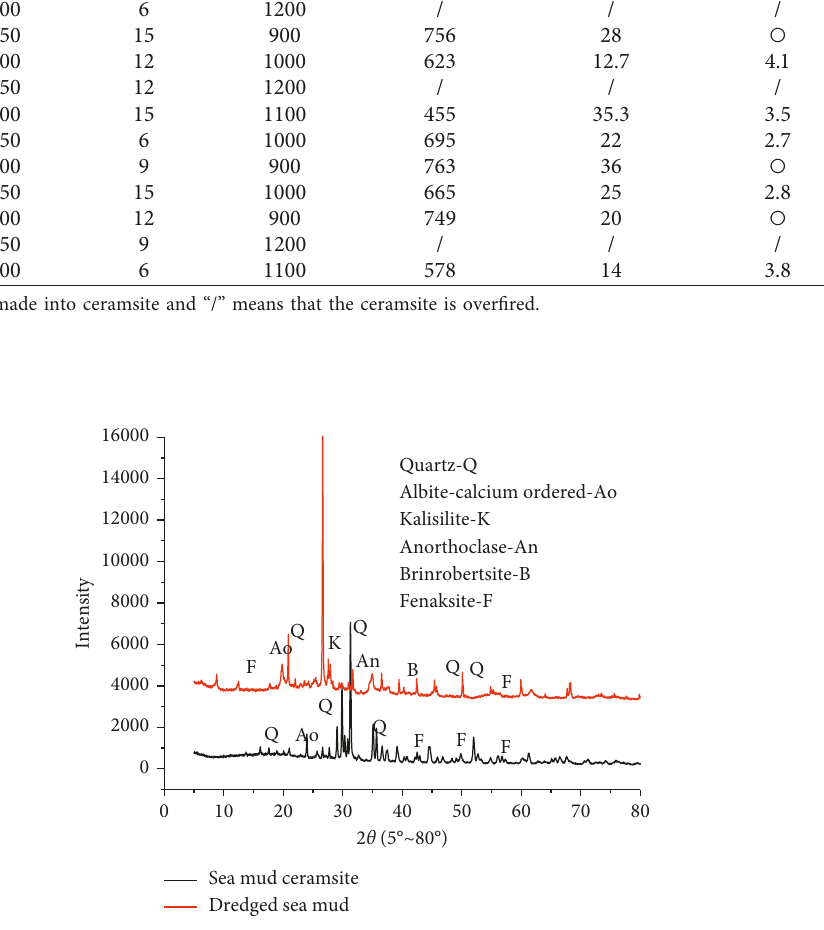
Figure 1: XRD analysis results on DSM and ceramsite. Q: quartz; Ao: albite-calcium ordered; K: kalisilite; An: anorthoclase; B: brin- robertsite; F: fenaksite.